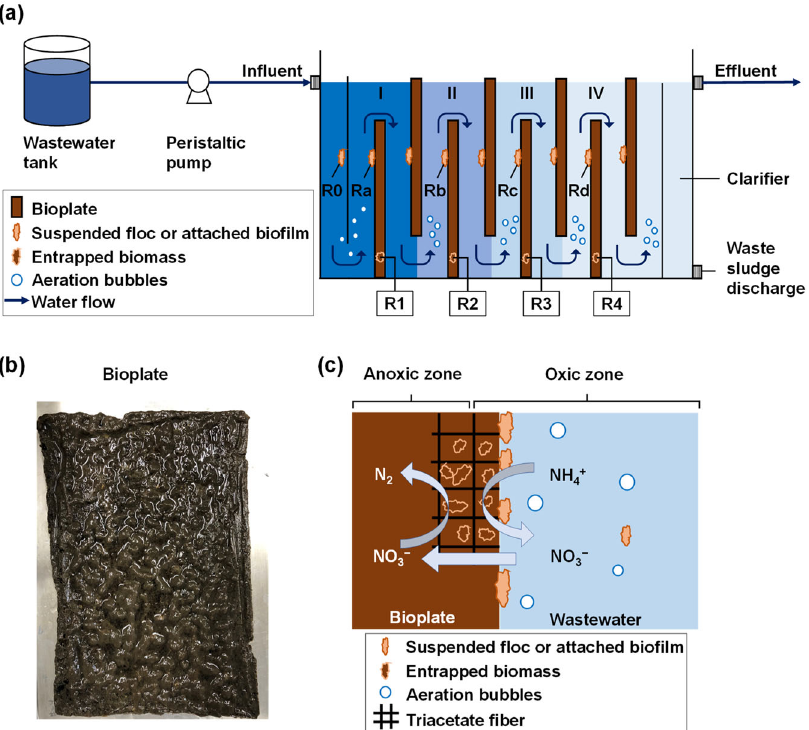
Fig. 1 Schematic of the immobilized bioplate reactor (IBPR). a Design of the bioreactor; b photograph of a bioplate; c presumed SND pathway of the immobilized biomass process. (I – IV represent the compartments for water sampling; R0 represents the background suspended fl ocs; Ra – Rd and R1 – R4 represent the attached bio fi lms and the biomass entrapped in the bioplates, respectively, sampled for microbial community